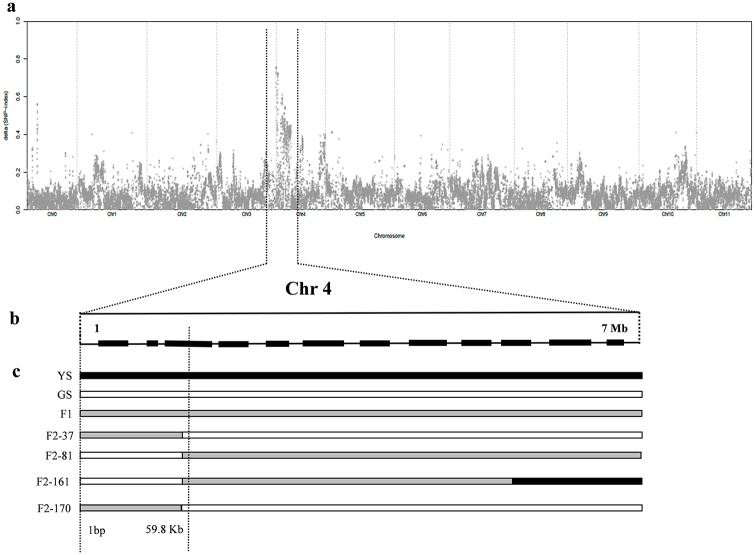
Fine mapping of the watermelon yellow skin trait.a: Δ (SNP-index) graph from the QTL-seq analysis; b: The yellow skin was identified to an interval of 1–7 Mb on chromosome 4. c: The candidate gene was narrowed to a 59.8 kb interval according to 4 recombine individuals in F2 population. YS: yellow skin; GS: green skin. Yellow skin was dominant.